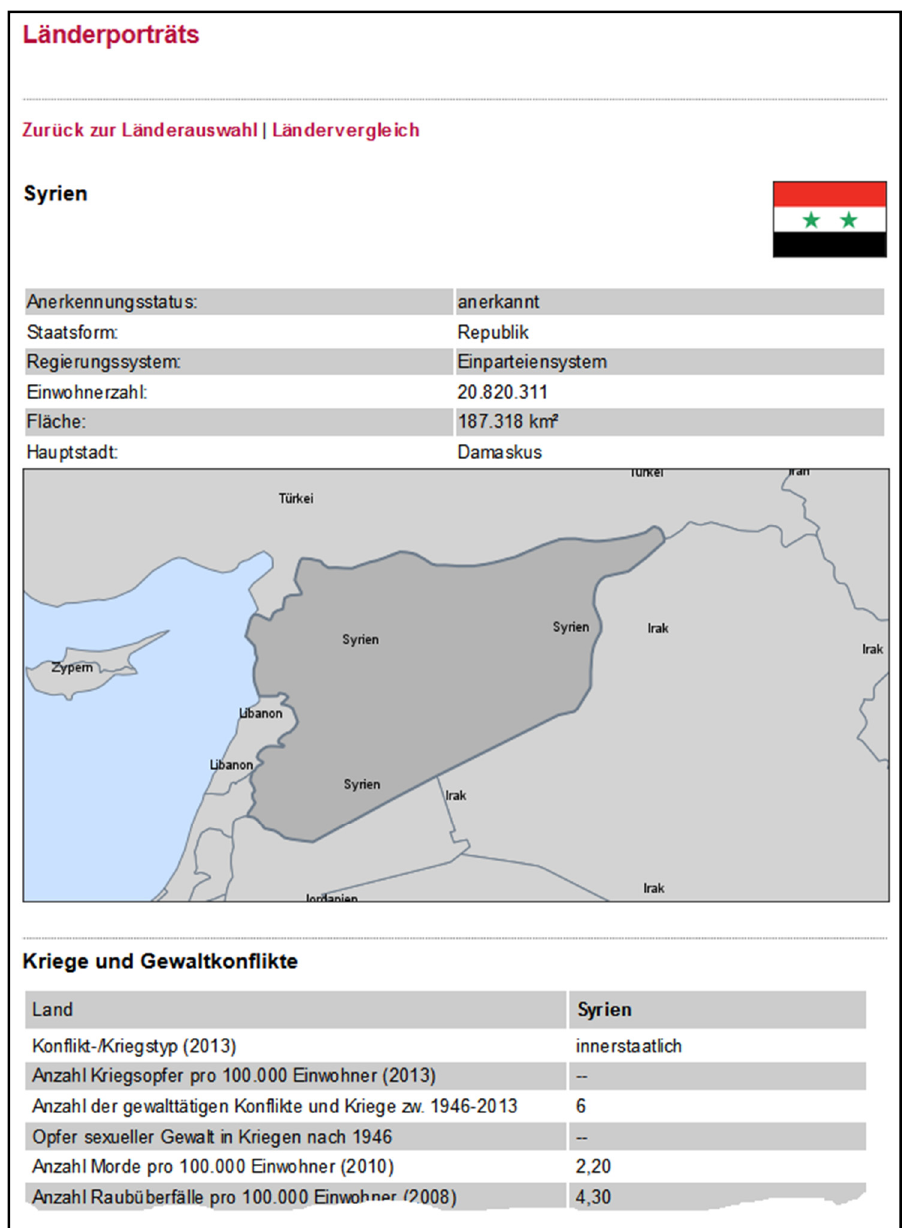
Figure 4. Screenshot—Country portrait of